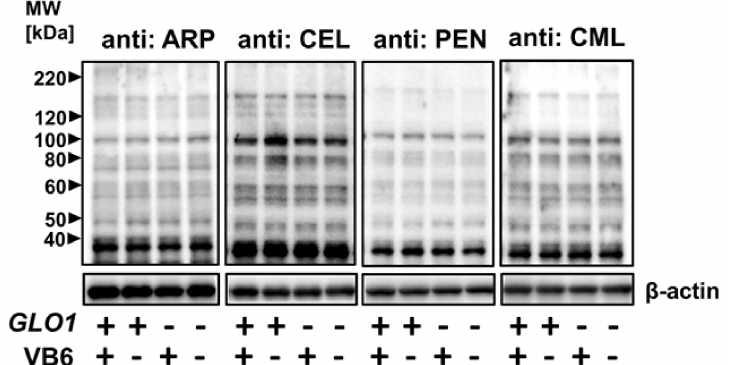
Figure 2. Detection of various AGEs-modified proteins in HIP. ARP, CEL, PEN, and CML-modified protein levels were detected by Western blot analysis in HIP obtained from four mice experimental groups. A typical result from the other two samples providing similar results is